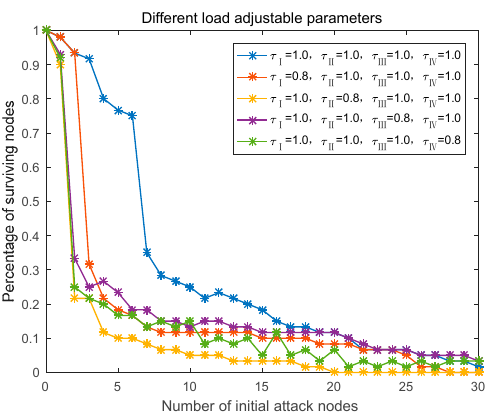
Figure 14. Effect of different load adjustable parameters on system survivability.